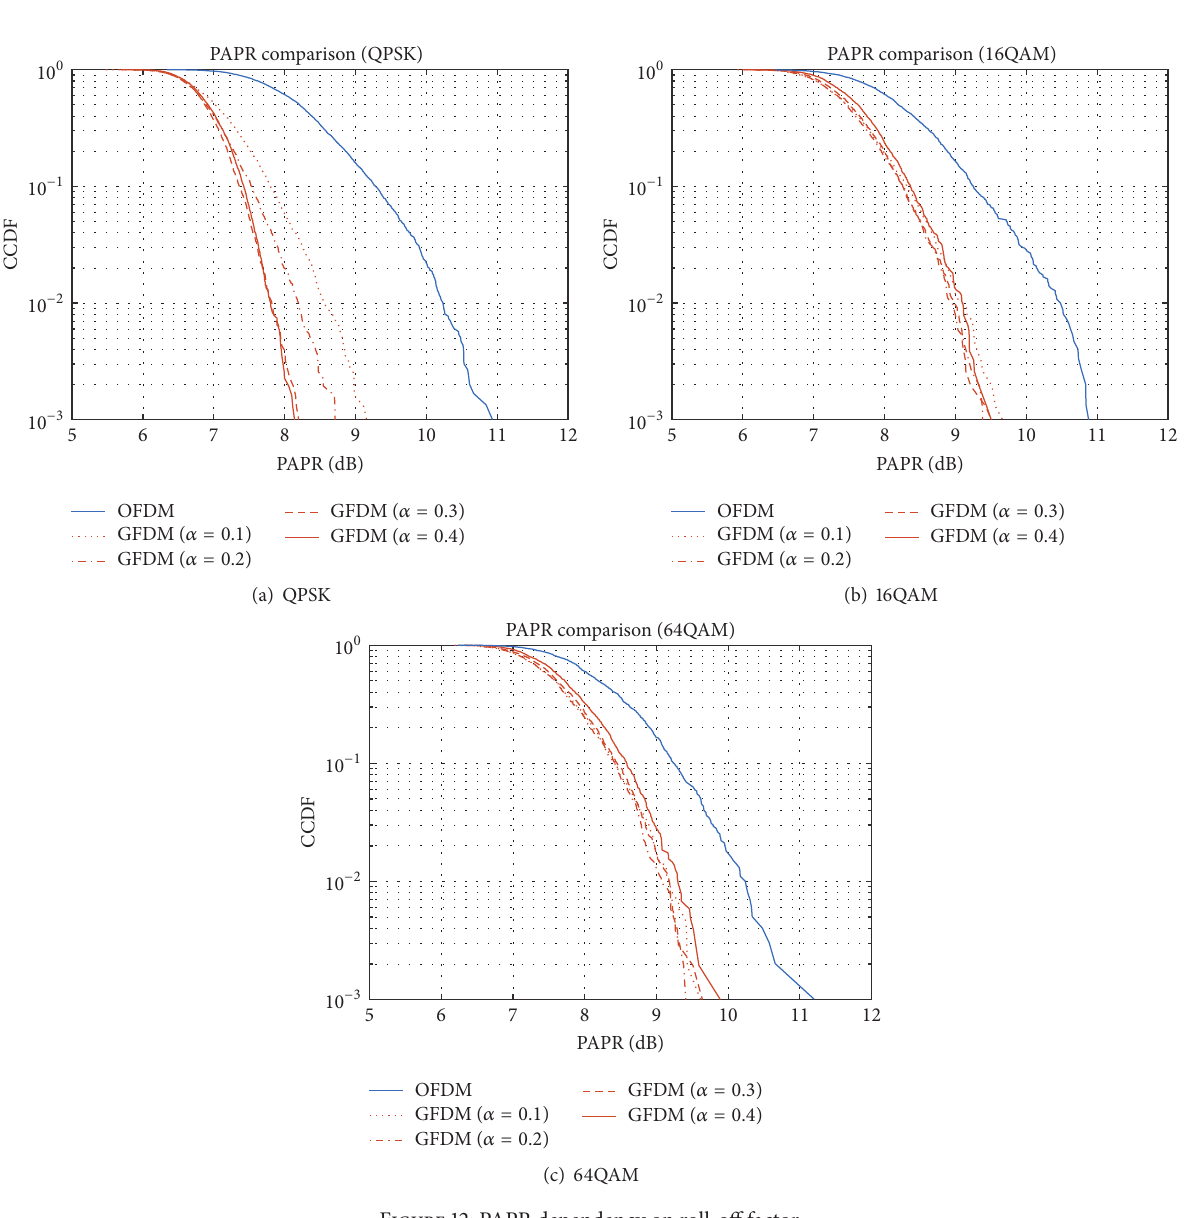
Figure 12: PAPR dependency on roll-off